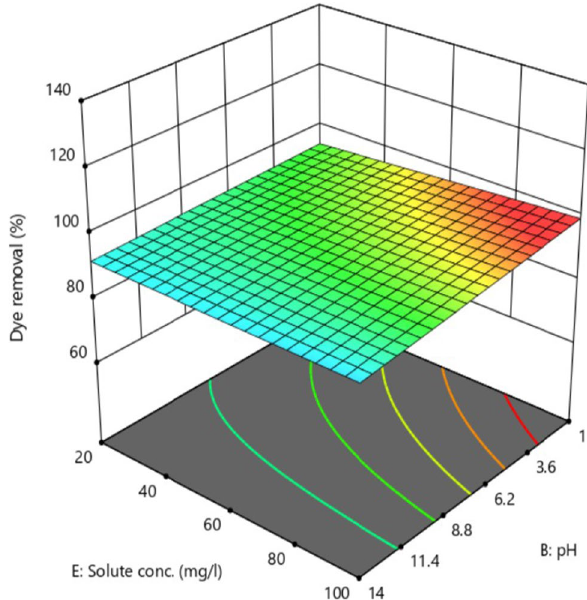
Fig. 23 Surface view showing the relation relative variation of per- centage dye removal with solute concentration and pH